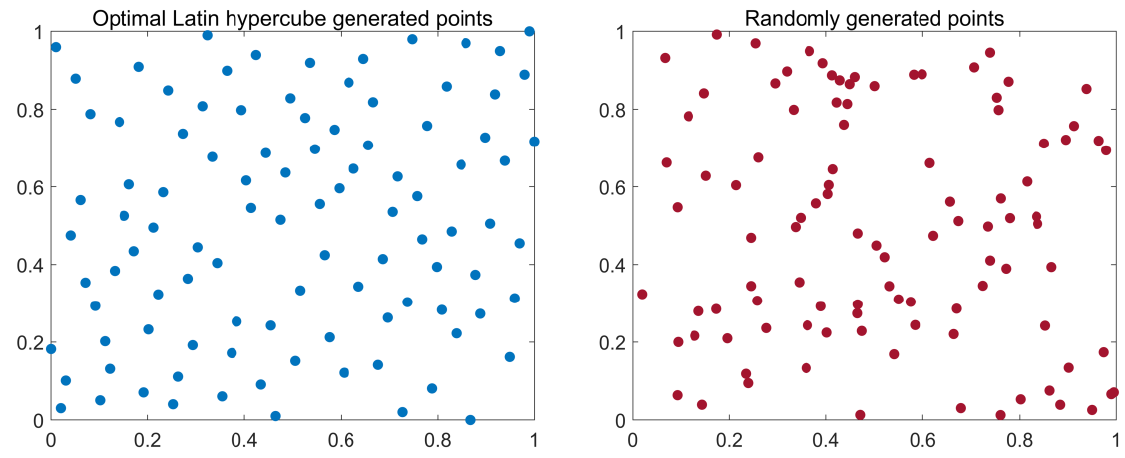
Figure 3. Comparison between generating point of OLHS and random generating point.